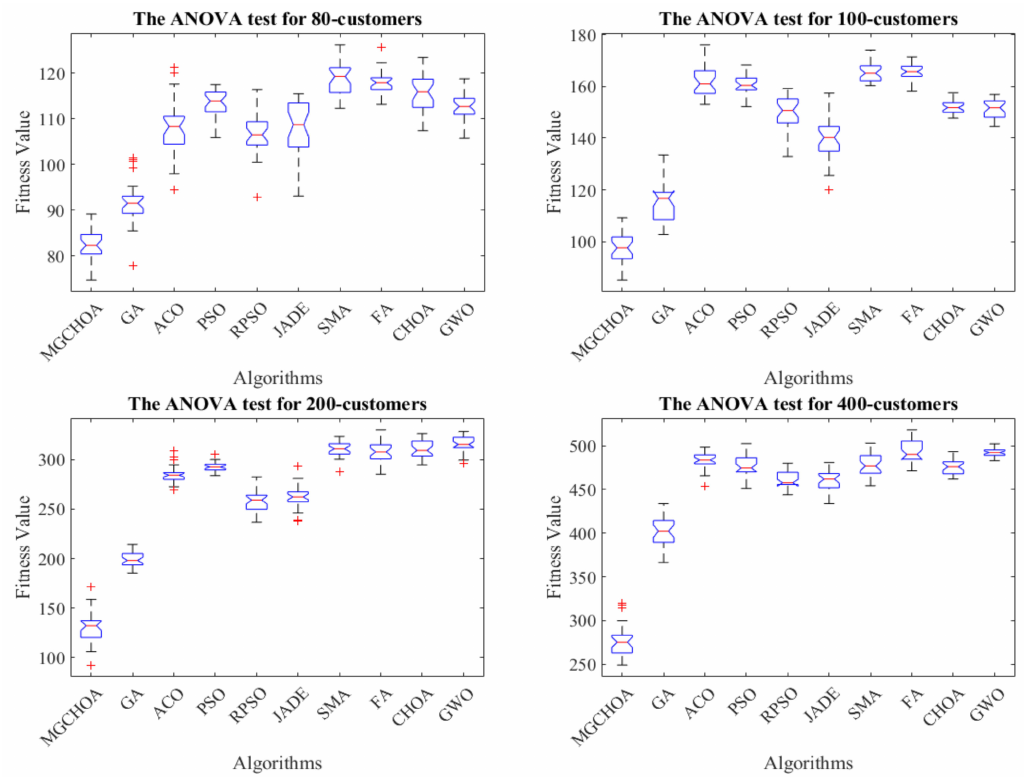
Figure 11. The ANOVA tests of the results after 30 runs, the blue box denotes the data distribution, the red line represents the median value, and the red symbol denotes the abnormal value.